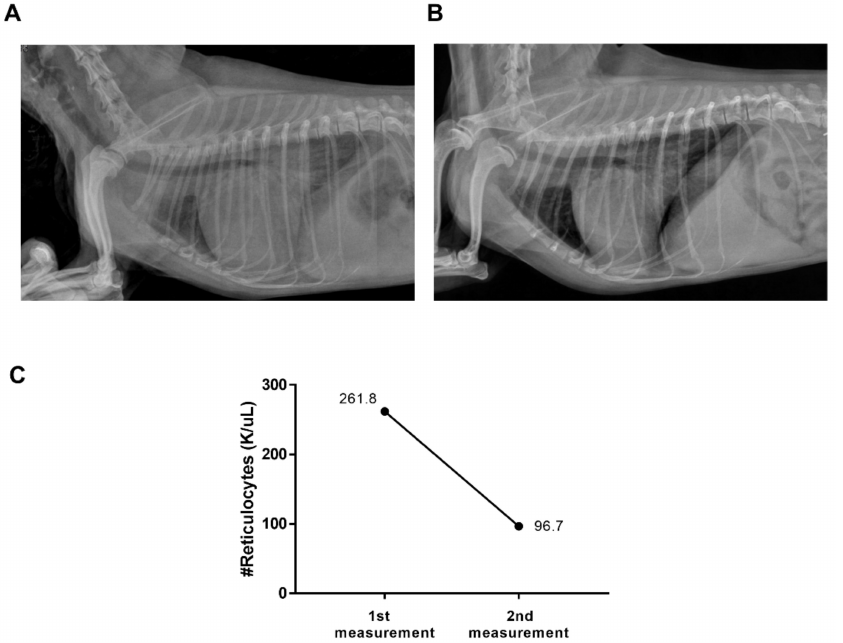
Figure 3. Representative case of this study. ( A ) Right lateral view of a radiography taken in an emergency visit due to cardiogenic pulmonary edema (CPE) with myxomatous mitral valve disease (MMVD). ( B ) Right lateral view of a radiography of the same case after resolution of CPE due to MMVD. ( C ) The absolute reticulocyte was decreased from 261.8 K/ µ L to 96.7 K/ µ